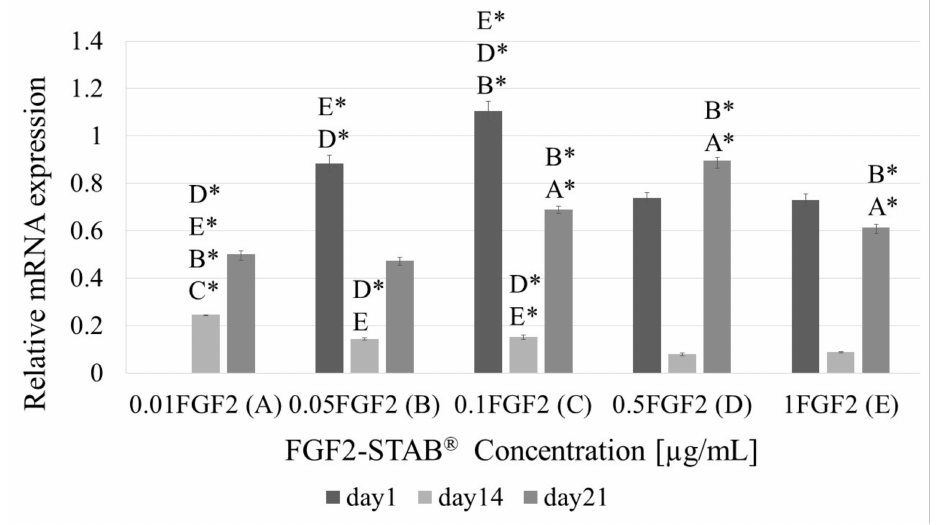
Figure 10. Relative collagen I mRNA expression of samples with increasing FGF2-STAB ® concentra- tion (0.01, 0.05, 0.1, 0.5 and 1 µ g/mL, for A – E , respectively) after 1, 7, 14 and 21 days of incubation. Statistical significance for p < 0.05 or * p <